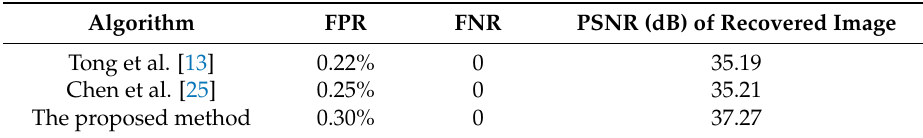
Figure 10. Partial enlarged details of the restored images: ( a ) Original ship image; ( b ) restored ship image using the method in [13]; ( c ) restored ship image using the method in [25]; ( d ) restored ship image of the proposed method. To highlight the differences among these restored images, some regions in restored images are selected and circled in red. Table 6. Performance comparisons for image deletion attack using Venice